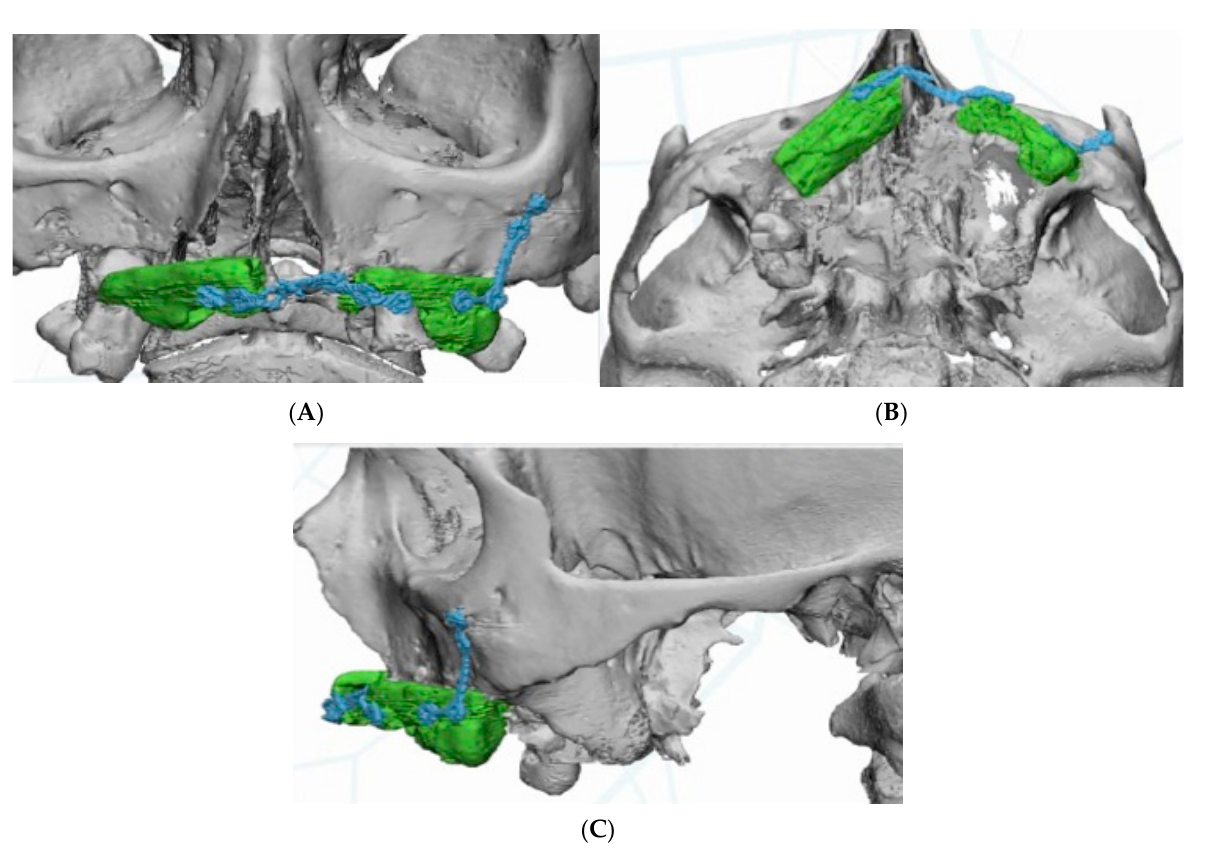
Figure 3. 3D reconstruction of the residual bone of the fibula flaps. ( A ) Frontal view. ( B ). Basal view. ( C ) Lateral view.